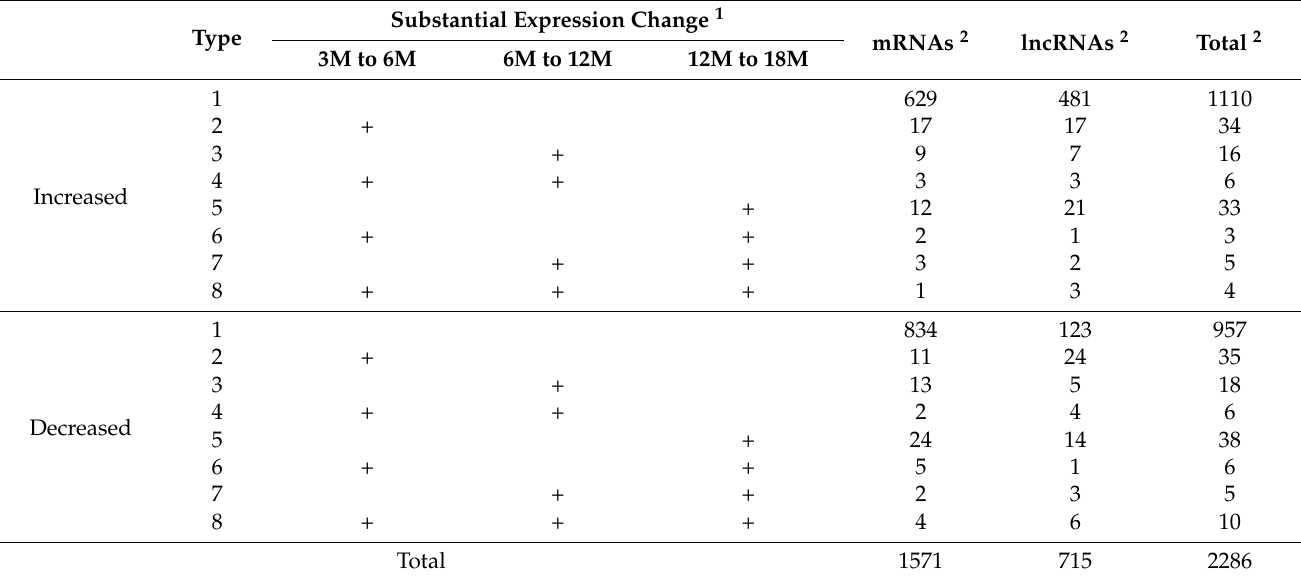
Table 2. Summary of aging-related transcript expression pattern in mouse testes.